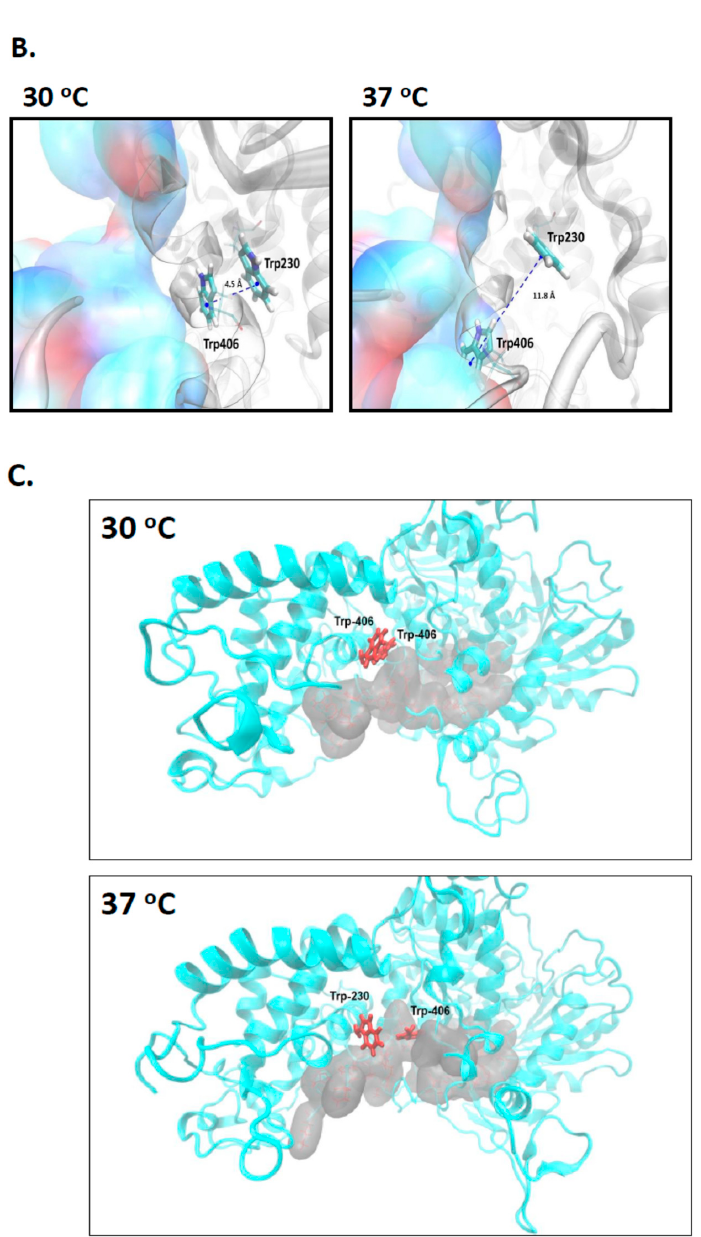
Figure 3. Molecular dynamics simulations indicate significant temperature-induced changes in positioning of Trp-230 and Trp-406. A. Shows the distances between the centre of phenyl rings of Trp-230 and Trp-406 monitored during the MD simulations at 30 °C and 37 °C, as indicated. B. Structures obtained during the final phase of MD simulations. The panel left side shows the Trp-230 and Trp-406 π - π interaction at 30 °C that is disrupted at 37 °C (panel right) because Trp-406 is moved into the pocket where it is stabilized by hydrophobic interactions within the ssDNA tunnel, shown as surfaces representing Thr-392, Gln-402, Gln-405, Leu-407, Gln-409, Lys-412, Lys-435, His-436, Asp-780 and Asp-778. C. Temperature-induced changes in the posi- tioning of Trp-230 and Trp-406 result in Trp-406 movement and blockage of the ssDNA binding channel (shown as grey surfaces representing the residues that form it), which we propose explains the lack of nuclease activity shown by E. coli Cas3 at the higher temperature, and its alleviation by replacing tryptophan with alanine. Cas3 protein is coloured in Cyan and Trp-230 and Trp-406 are coloured in red. At 37 °C Trp-406 moves to a location within a pocket in the ssDNA tunnel.